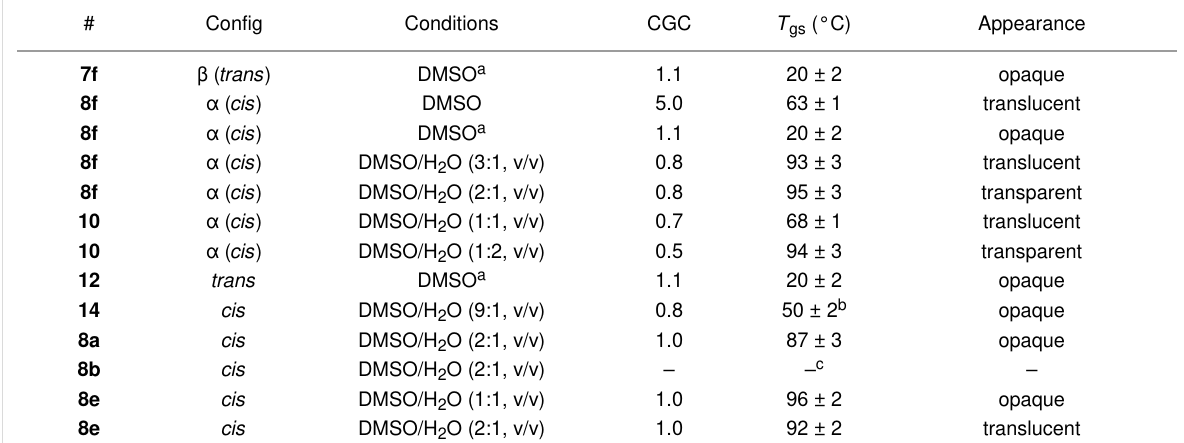
Table 2: Critical gelation concentration (CGC, in % w/w) and gel–sol transition temperature ( T gs , via dropping-ball method) for compounds 7f , 8a , 8b , 8e , 8f , 10 , 12 , and 14